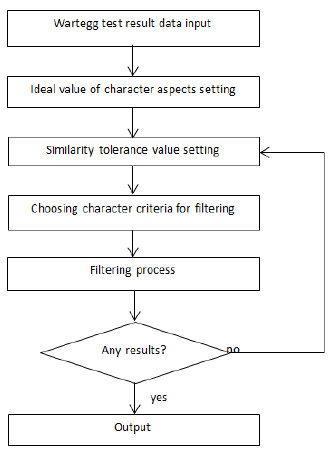
Fig. 2. Data similarity filtering process of Wartegg test results